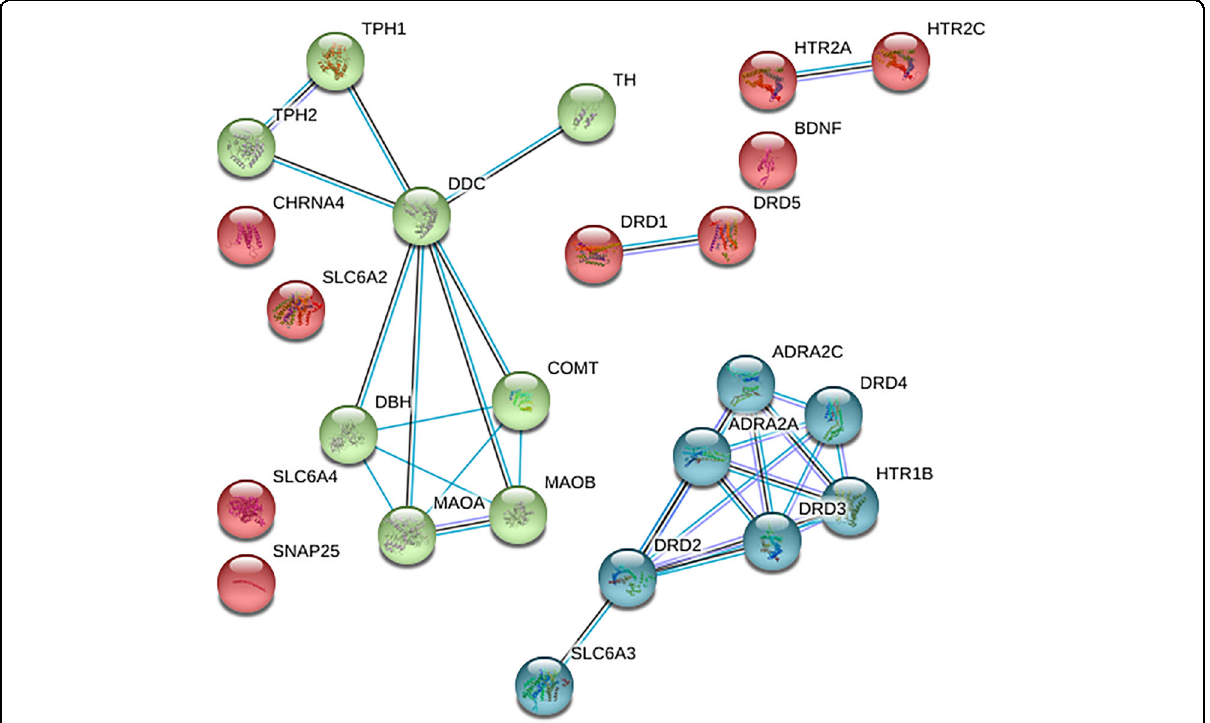
Fig. 4 Interaction map of hot genes associated with various parts of brain changes as observed on structural and functional MRI in attention-de fi cit hyperactivity disorder, generated using STRING1 webserver. All sources are used to create the interaction model with a default medium con fi dence interaction score of 0.4. and k -means clustering method. The line color indicates the type of interaction evidence: blue line denotes co-occurrence, black line indicates co-expression, and the purple line indicates experimental evidence ref: